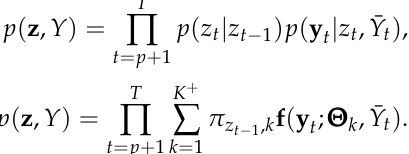
which are in turn sampled t